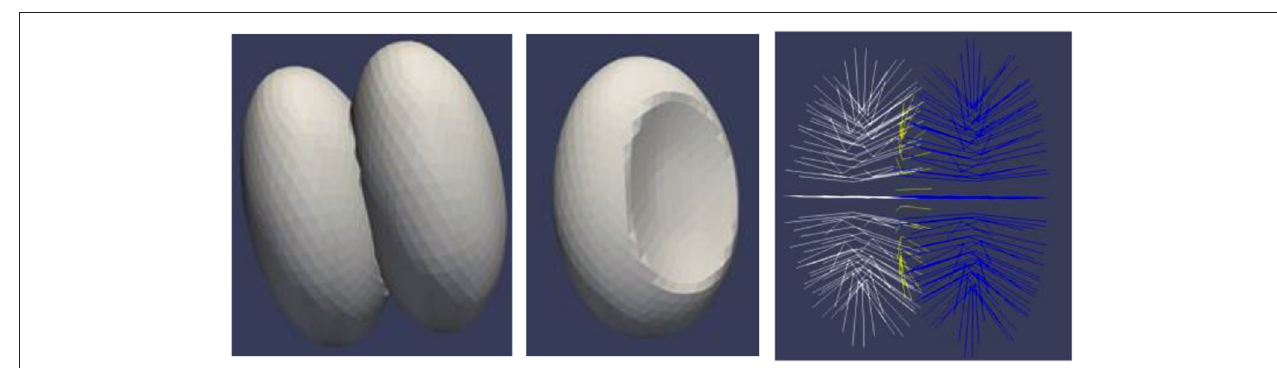
FIGURE 13 | Ellipsoidally based objects with a shared boundary that are used as data. Left: The two objects. Middle: one of the objects, showing the region of shared boundary. Right: the 2 object s-reps and the shared boundary s-rep (yellow).